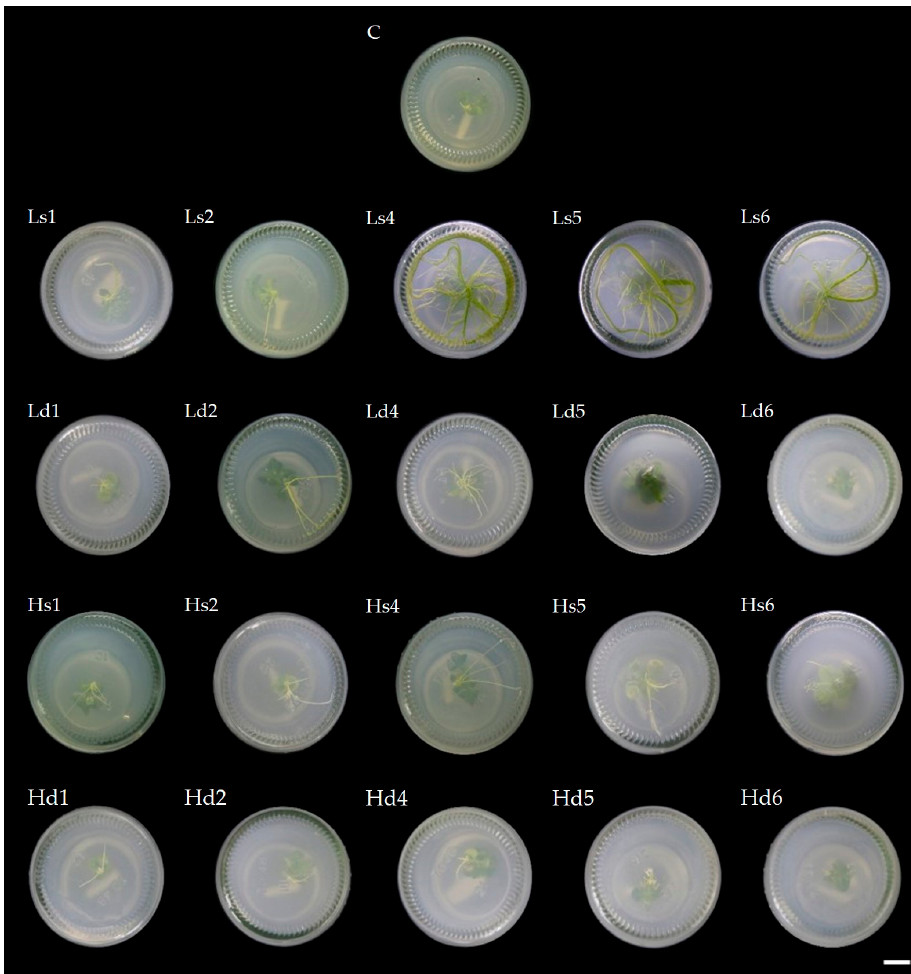
Figure 1. Effect of low ‐ and high ‐ intensity UV ‐ C with single or double irradiation on Persian violet root initiation after subsequent culturing for 4 weeks: C = control; L = low ‐ intensity; H = high ‐ intensity; s = single irradiation; d = double irradiation; 1, 2, 4, 5, 6 = 1, 2, 4, 5, and 6 h (scale bar = 1 cm).